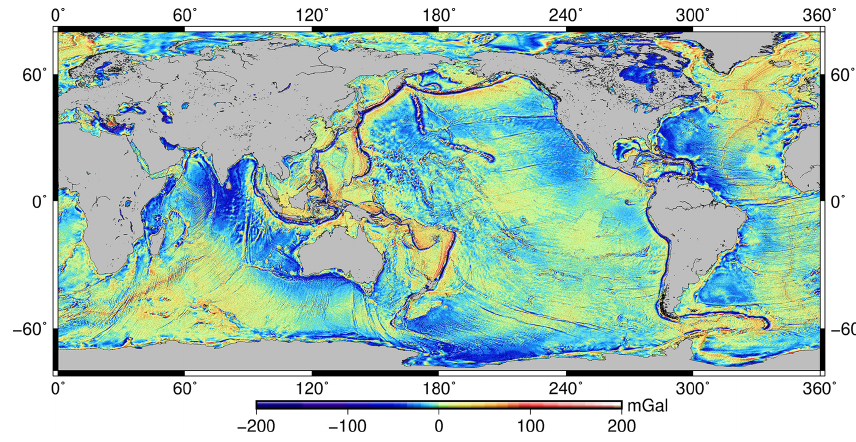
Figure 5. The marine gravity anomaly model of